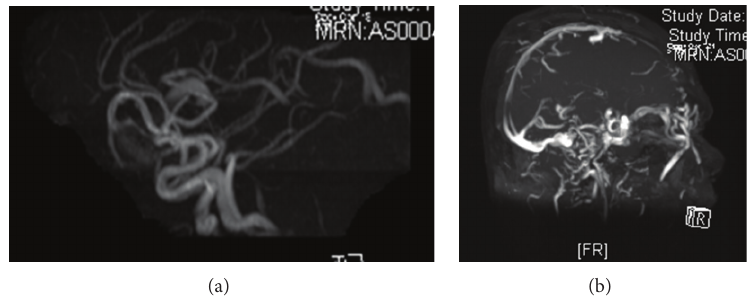
Figure 4: MRA confirmed right temporal arteriovenous malformation with no carotid-cavernous